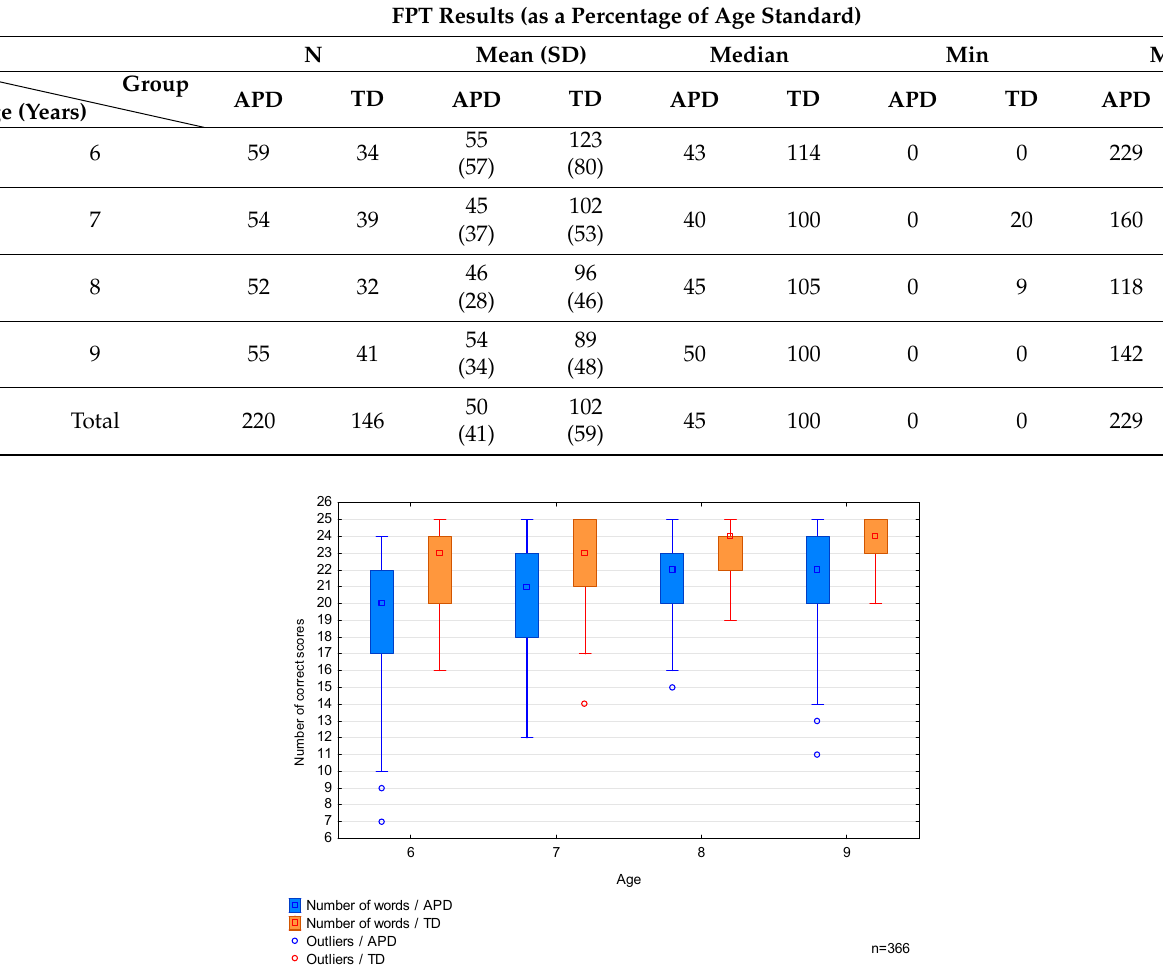
Table 4. Basic statistics describing the results of FPT, presented as a percentage of age standard, in APD and TD groups, by age.